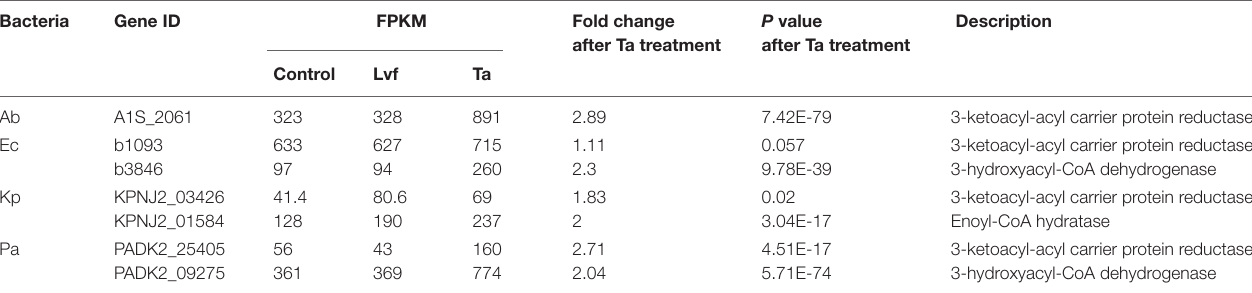
TABLE 2 | Differentially expressed genes in the biosynthesis of unsaturated fatty acids pathways after treatment. Bacteria Gene ID FPKM Fold change